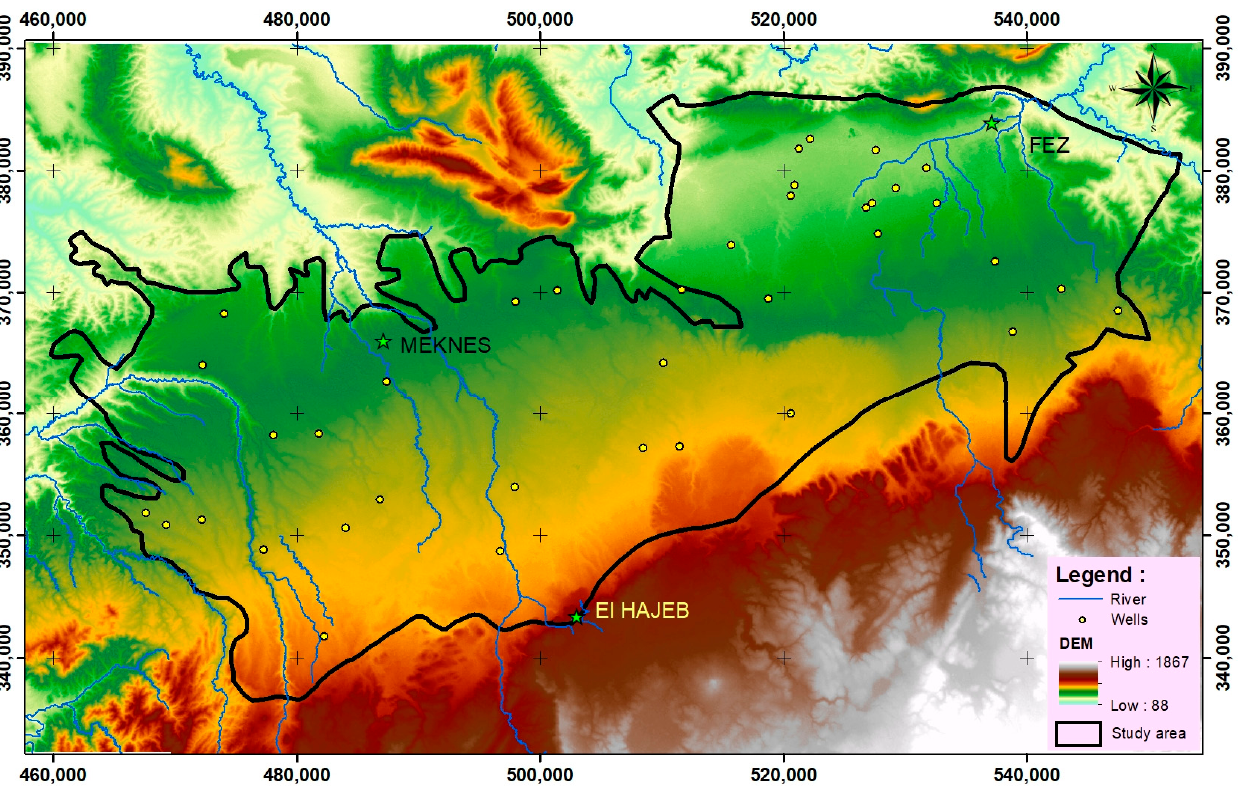
Figure 1. Geographic location map of the study area.